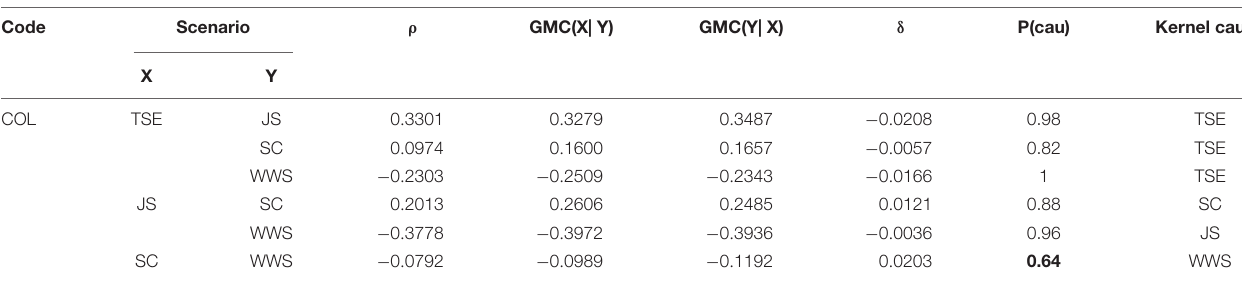
TABLE 5 | Summary of GMC for Colombia.